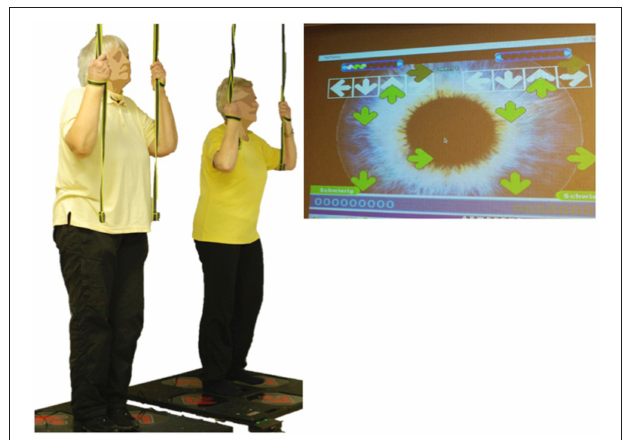
FIGURE 1 | Interactive cognitive-motor video game dancing (DANCE). Two participants perform steps on a pressure sensitive platform to the rhythm of the music. Step timing and direction are cued with arrows on a